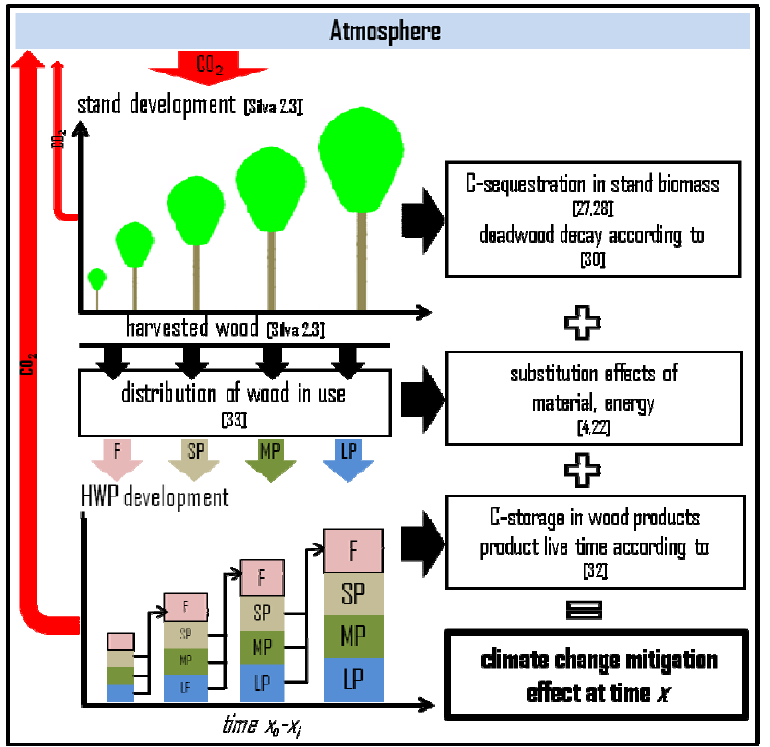
Figure 4. The model approach; LP = products with long lifetime, MP = products with middle lifetime, SP = products with short lifetime, F = fuel